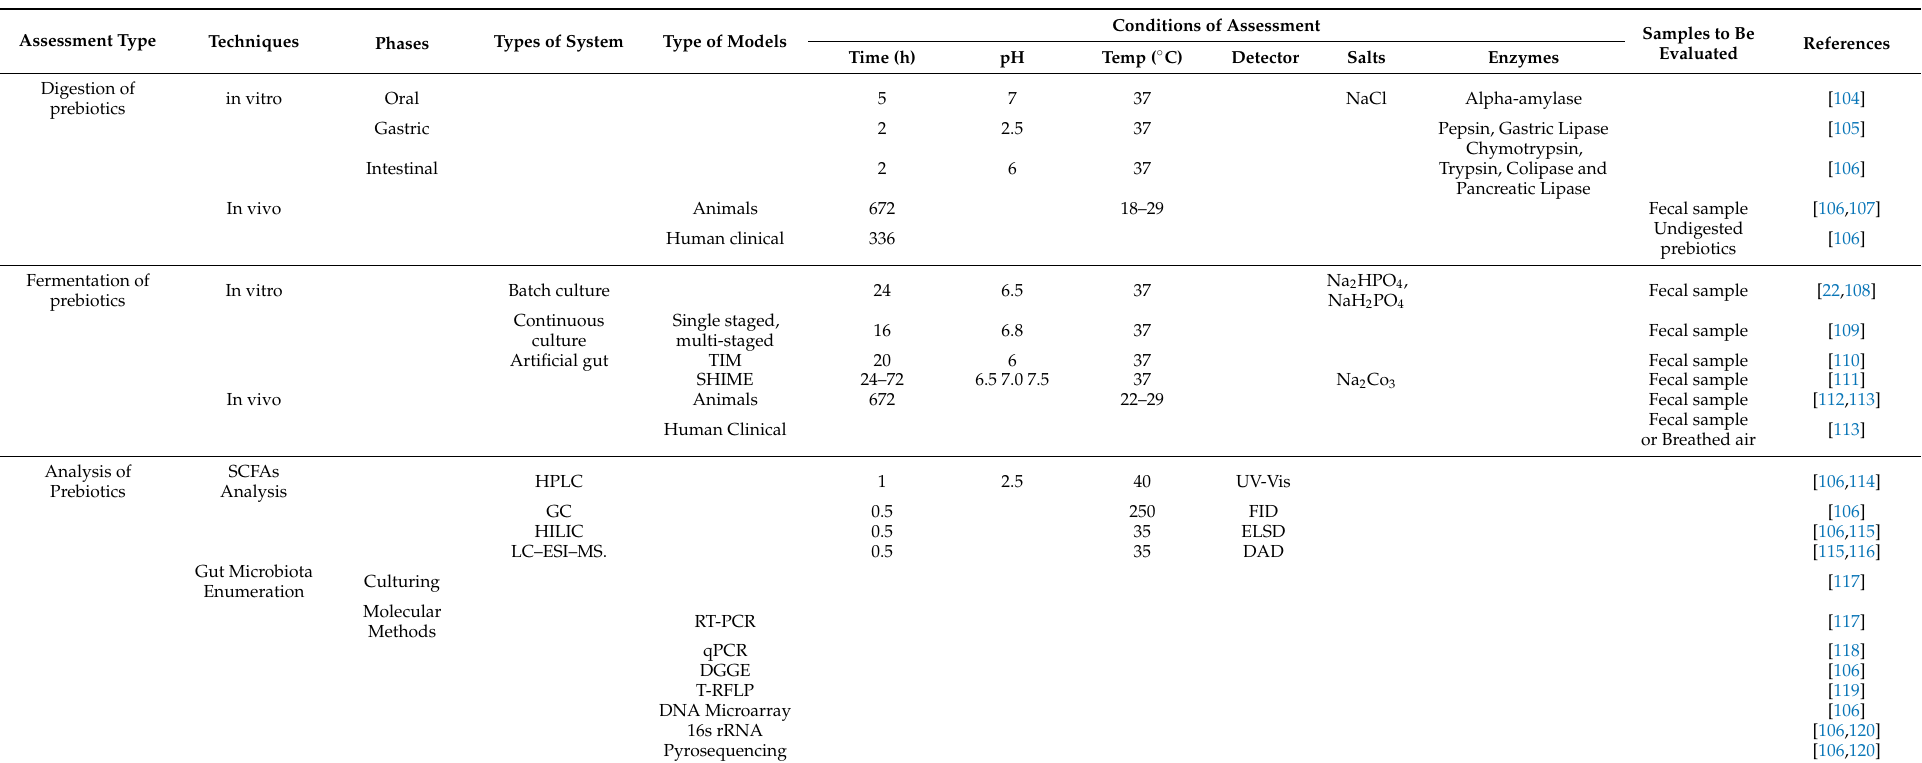
Table 2. Techniques used in the assessment of prebiotic